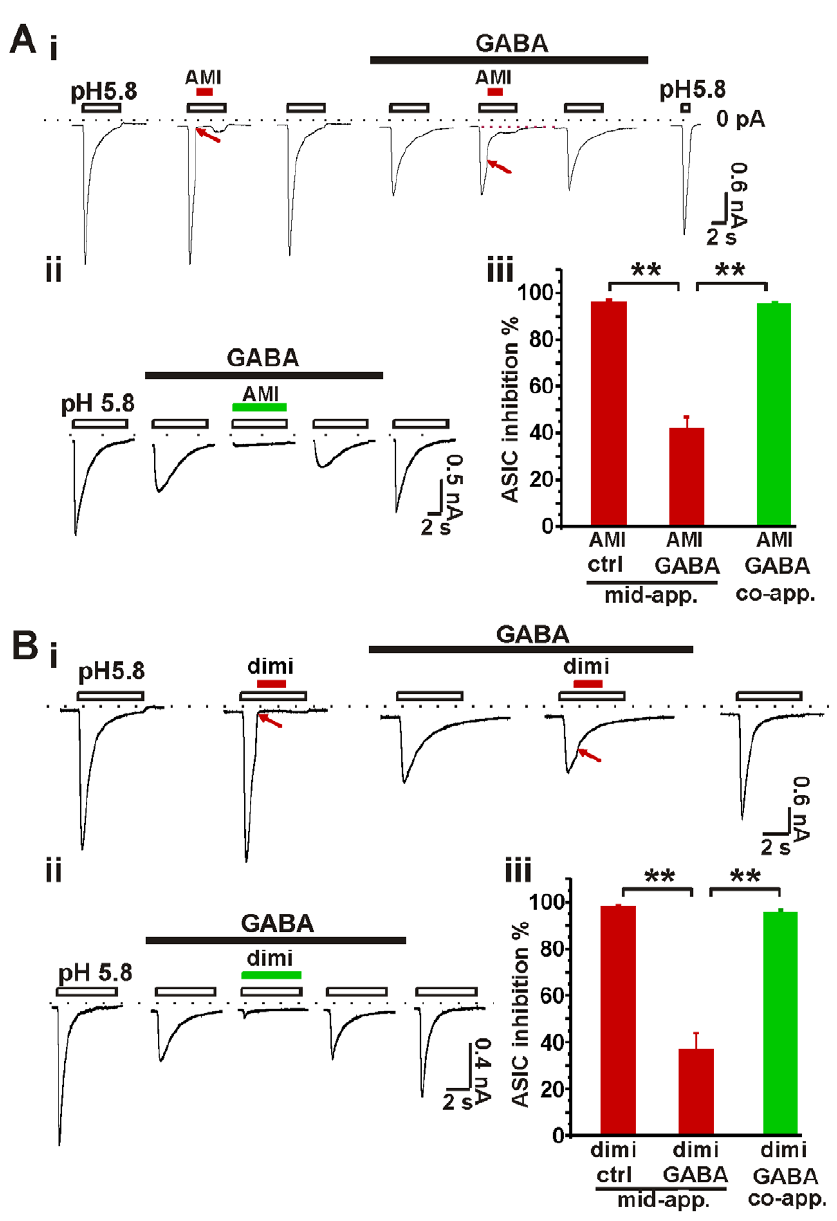
Figure 6. The pharmacology of ASICs is modified by GABA. A, the ASIC blockade by amiloride was altered by activation of GABA A receptors. i, representative traces of ASIC currents. Middle-applied amiloride (AMI, 200 m M) fully blocked ASIC currents. Application of GABA (100 m M) attenuated the ASIC currents and also reduced the degree of blockade by middle-applied amiloride, n=8. Red arrows denote the difference of ASIC blockade by amiloride in the absence or presence of GABA. ii, in the presence of GABA, co-applied amiloride (AMI, 200 m M) fully blocked ASIC currents, n=7. iii, bar graph showing a summary of the blockade of ASICs by amiloride (middle-applied vs. co-applied) in the absence or presence of GABA. **, p , 0.01. B, the ASIC blockade by diminazene was altered by activation of GABA A receptors. i, representative traces of ASIC currents. Middle-applied diminazene (dimi, 20 m M) completely blocked ASIC currents. Application of GABA (100 m M) attenuated the ASIC blockade by the middle-applied diminazene, n=6–7. ii, representative current traces showing that in the presence of GABA, co-applied diminazene (dimi, 20 m M) fully blocked ASIC currents, n=7. iii, bar graph showing the statistics of the inhibition of ASICs by diminazene (middle-applied vs. co-applied) in the absence or presence of GABA. **, p , 0.01. ASIC current at the presence of blockers was normalized to a measured ASIC current before applying blockers, which thereby obtained the inhibition percentage. mid-app. (middle-applied drug): first activated ASICs with pH 5.8, then applied blocker when part of ASICs were still open. co-app. (co-applied): ASIC blocker and pH 5.8 solution were applied